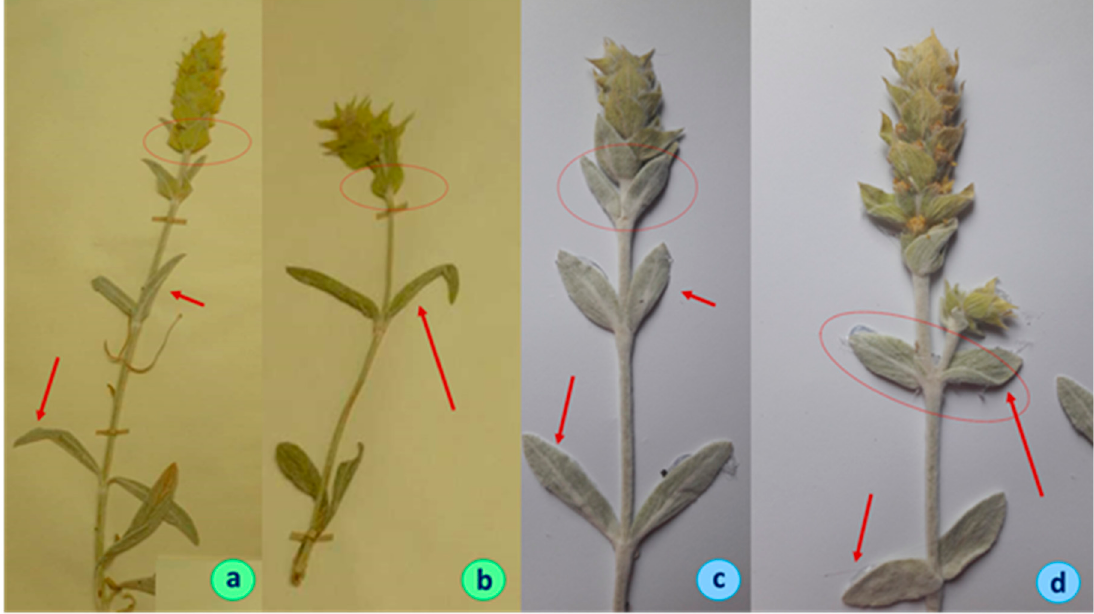
Figure 2. Herbarium specimens: S. scardica ( a , b ) and S. elica ( c , d ).